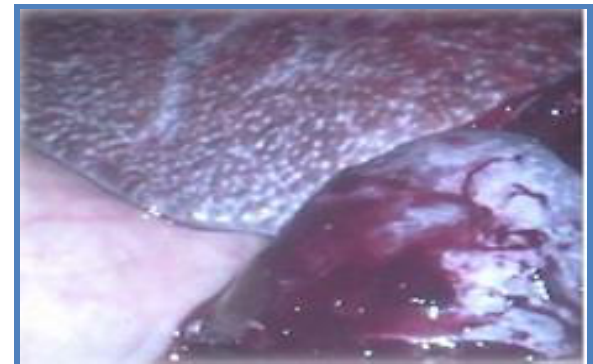
Figure, 5: Excised part of spleen near original spleen.